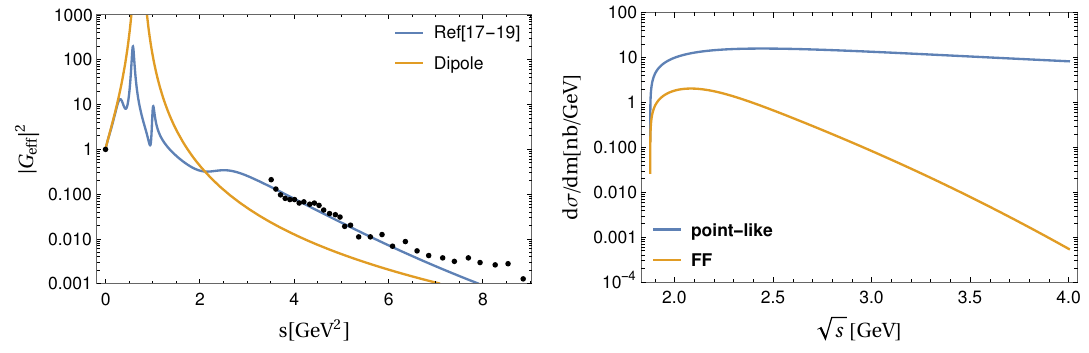
Figure 8 . Left: j G e(cid:11) j 2 in double proton production via e + e (cid:0) scattering, e + e (cid:0) ! p (cid:22) p , comparing data (black dots from [49]) with the phenomenological model from [17{19] (blue line) and the dipole approximation without absortive phase (yellow line). Right: contribution of proton exchange mechanism to the cross section of (cid:13)(cid:13) ! p (cid:22) p for j cos (cid:18) j < 0 :